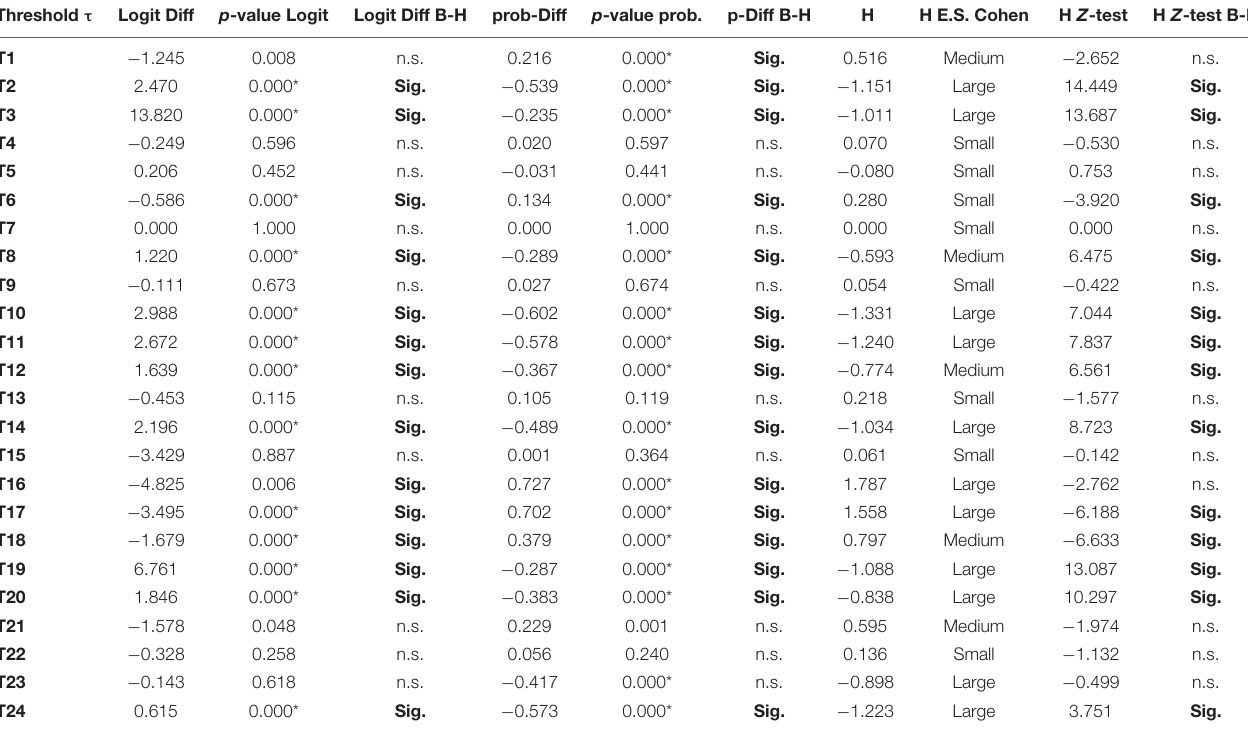
TABLE 6 | Differences between thresholds across waves (2017 vs. 2018) using logit and probability difference tests. Threshold